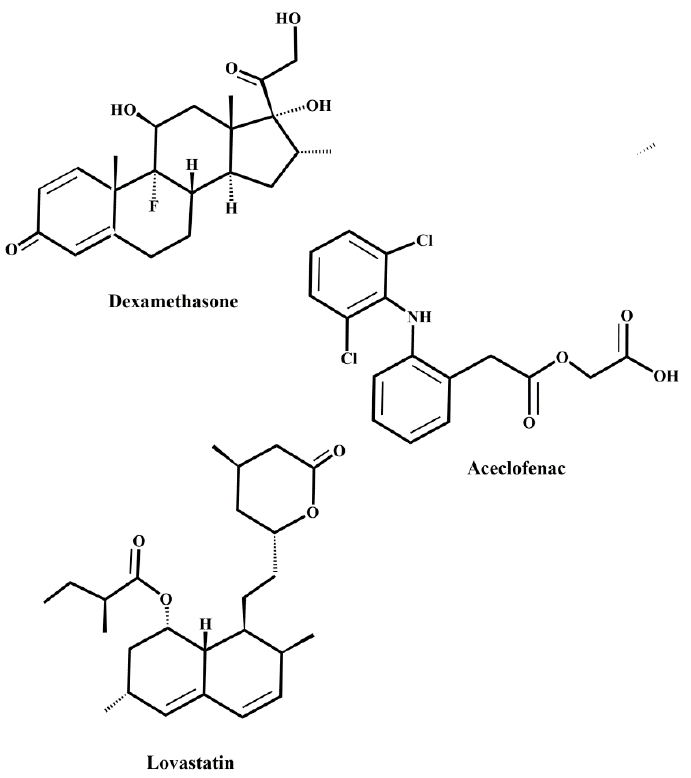
Figure 11. Schematic representations of dexamethasone, lovastatin, and aceclofenac, which are agents involved in the inhibition of selectin expression.